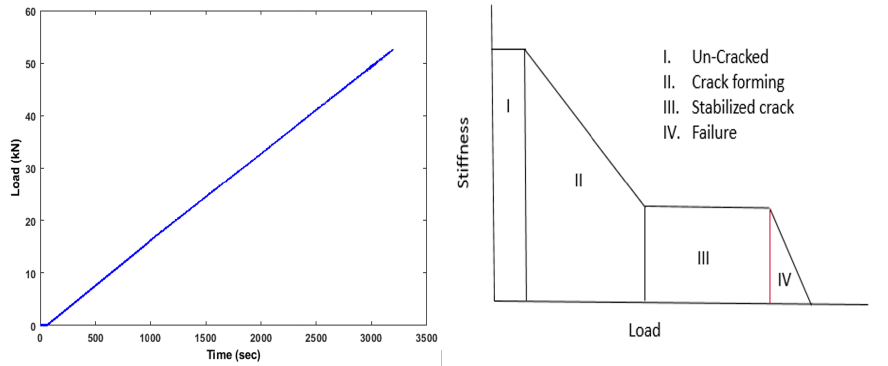
Figure 9. Generalized bending stiffness development where four phases are